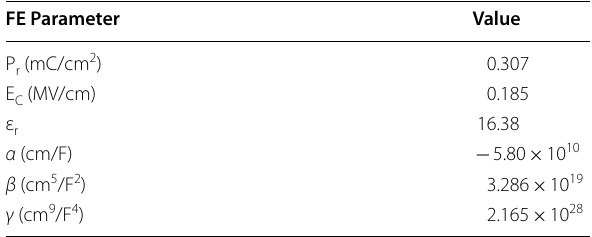
Table 3 The adopted HZO parameters which have been calibrated with the measured data [28]